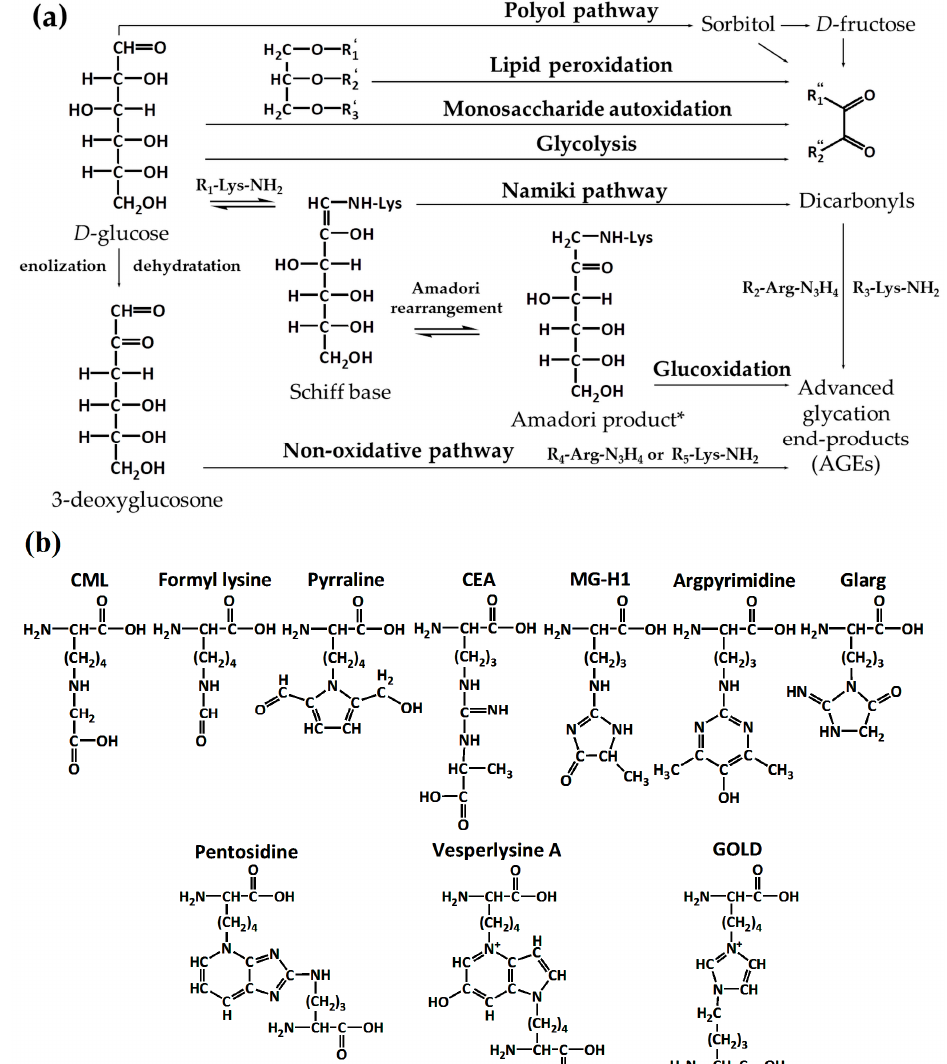
Figure 1. Pathways of early and advanced glycation (oxidative glycosylation [12], Namiki pathway [13], enolization [14], oxidative [15] and non-oxidative (enolization and dehydration stages are not mentioned) [16] degradation of early glycation products, polyol pathway [17] and lipid peroxidation [18] ( a ) and structures of major AGEs detected in vivo and in thermally processed foods ( b )). R 1 , R 2 , R 3 , R 4 , R 5 , polypeptide chains; R 1 ′ , R 2 ′ , R 3 ′ , fatty acid residues; R 1 ′′ = H, R 2 ′′ = H for glyoxal; R 1 ′′ = H, R 2 ′′ = CH 3 for methylglyoxal; R1 ′′ = H, R2 ′′ = C 4 H 9 O 3 for 3-DG. * Ketoses form so-called Heyns products.